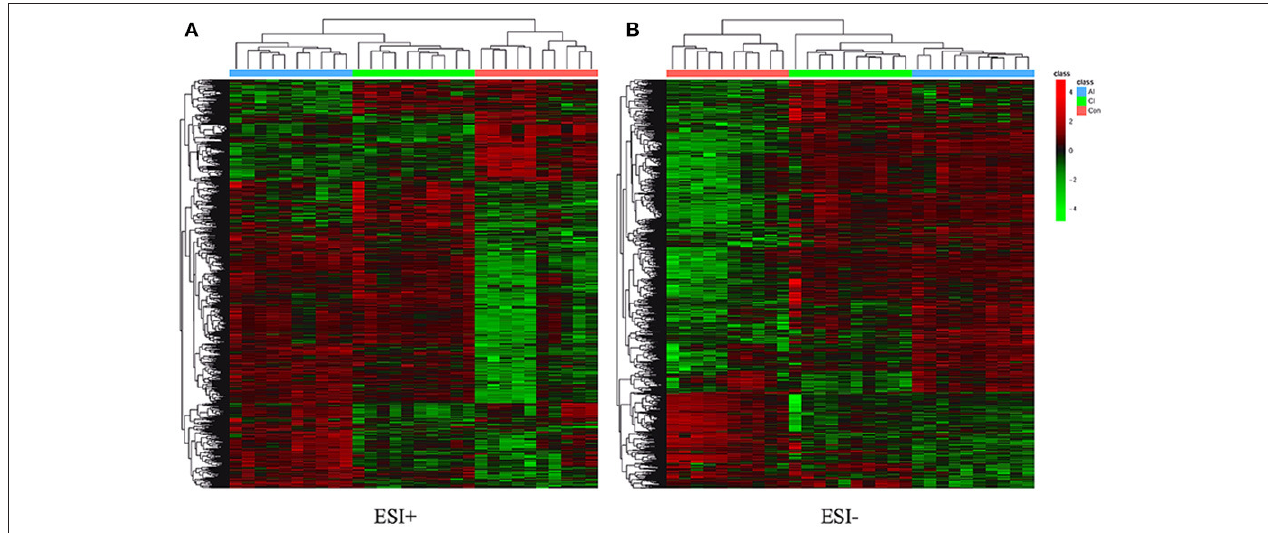
FIGURE 3 | (A) Heatmaps of the differential metabolites in acutely infected mice (AI) and chronically infected mice (CI) vs. control mice (Con) in the positive ion mode (ESI + ). (B) Heatmaps of the differential metabolites in acutely infected mice (AI) and chronically infected mice (CI) vs. control mice (Con) in the negative ion mode (ESI–). Red and green colors indicate values above and below the mean, respectively. Black indicates values close to the mean.